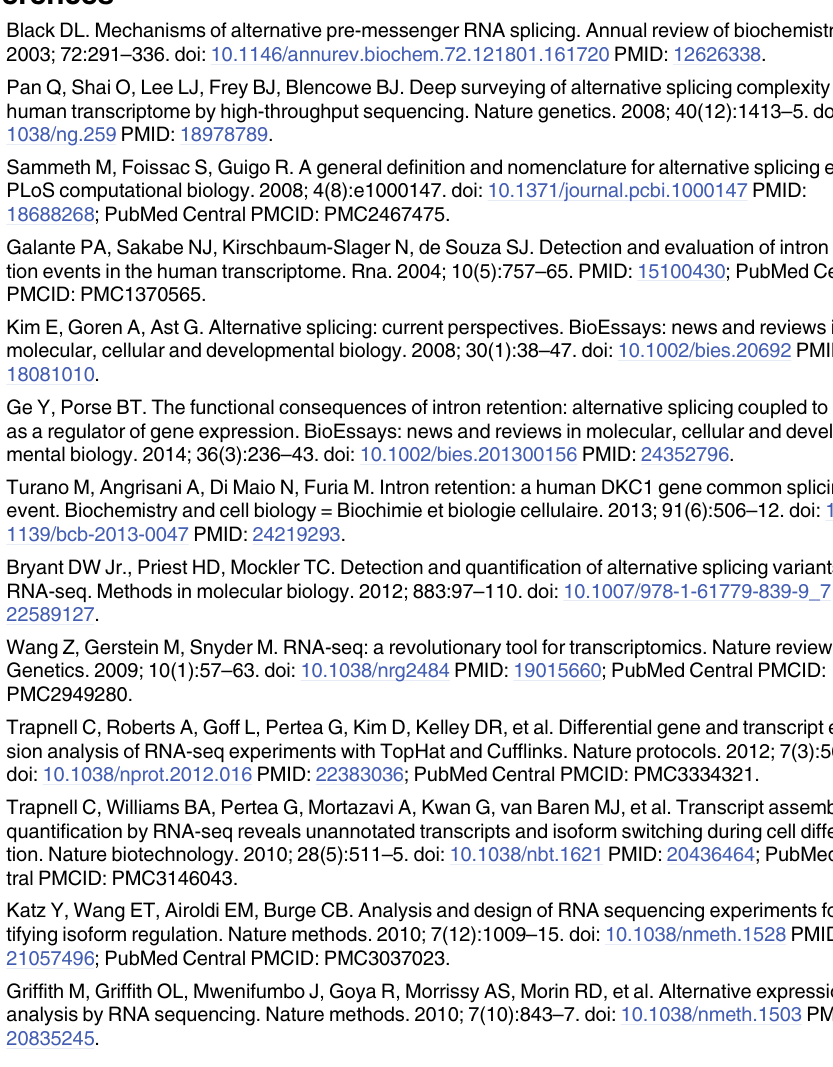
S2 Table. The list of significant intron retentions including partially retained introns. S3 Table. The result from the intron retention analysis for the plant Arabidopsis